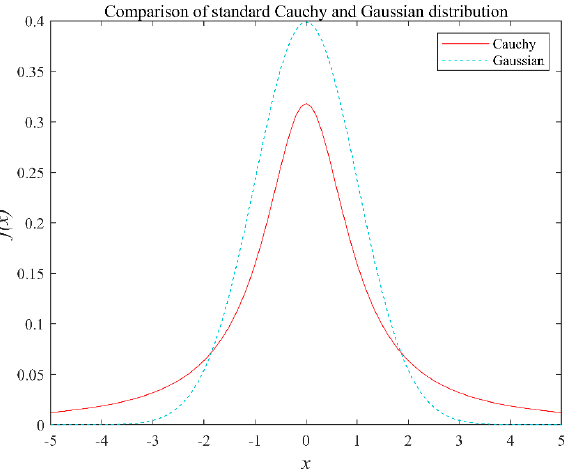
Figure 4. Probability density function curves for the standard Cauchy and Gaussian distributions.